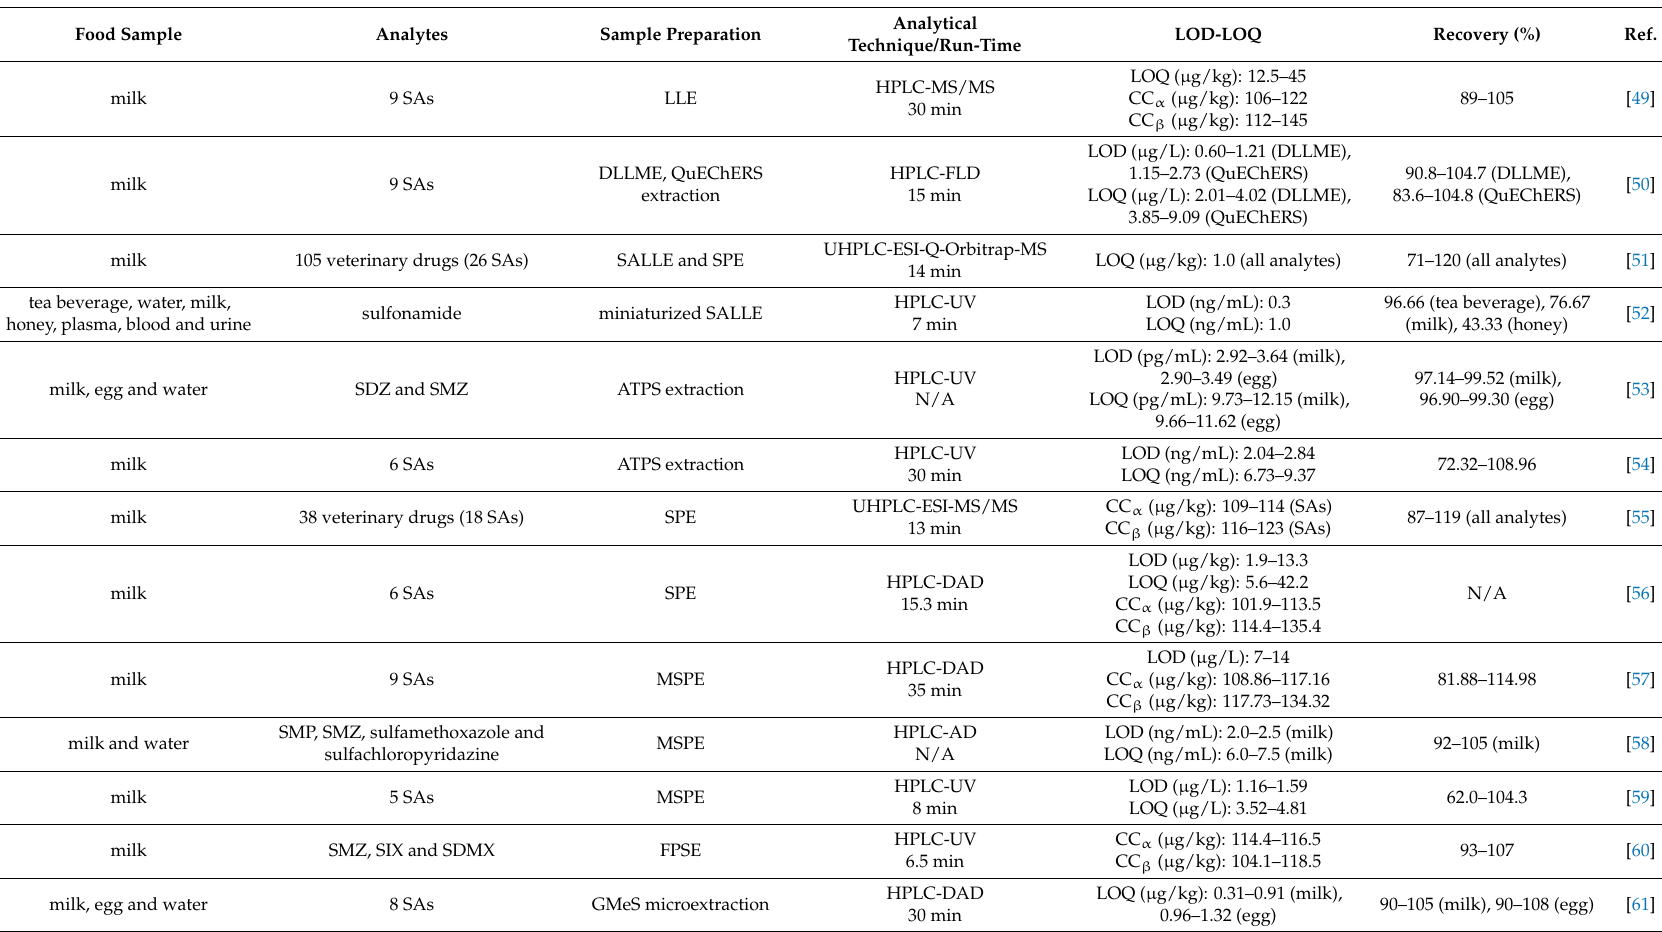
Table 3. Extraction of SAs from milk and milk product, egg, and honey